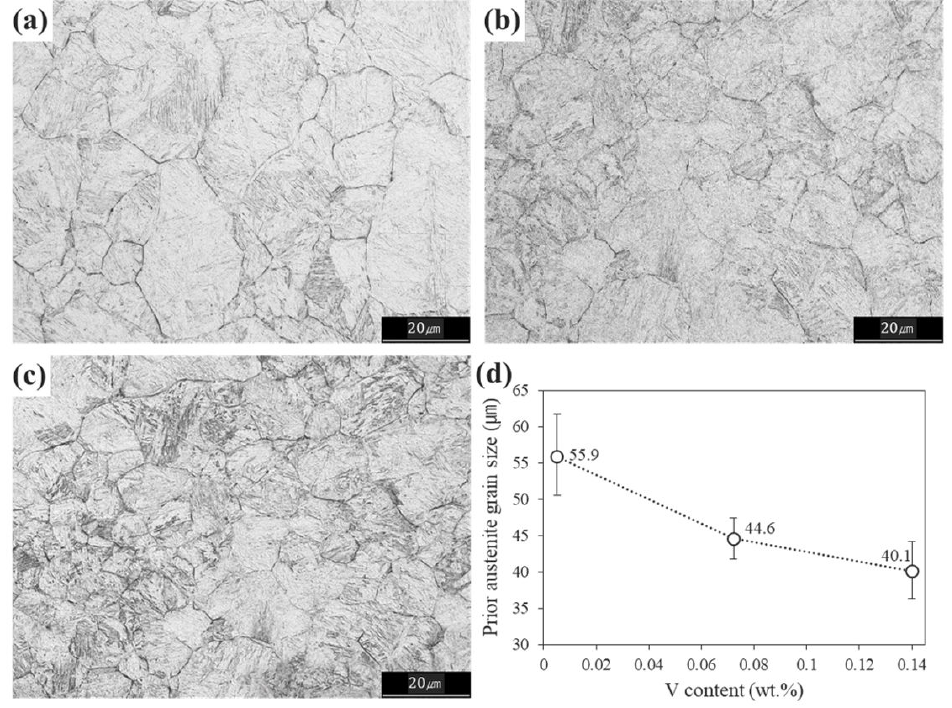
Figure 4. Images of the prior austenite grain and variation of PAGS with respect to V content: ( a ) RB V0, ( b ) RB V1, ( c ) RB V2, ( d ) PAGS behaviour as a function of V